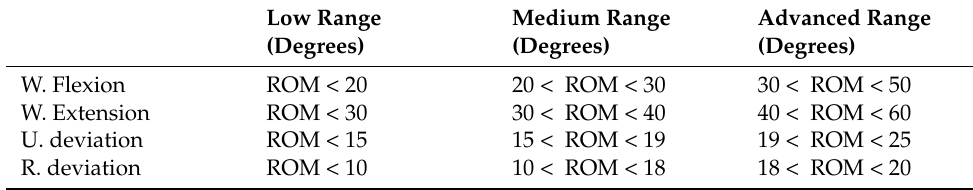
Table 3. Wrist Range Division.